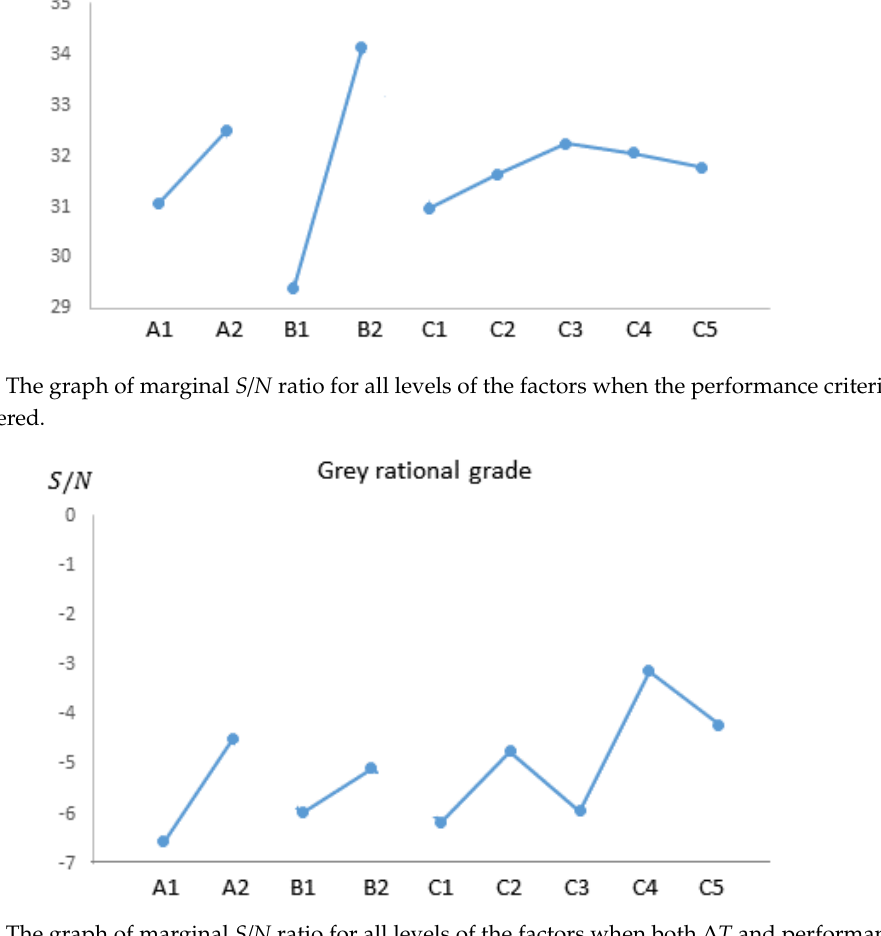
Figure 4. The graph of marginal S / N ratio for all levels of the factors when both ∆ T and performance (grey rational grade) criteria are considered